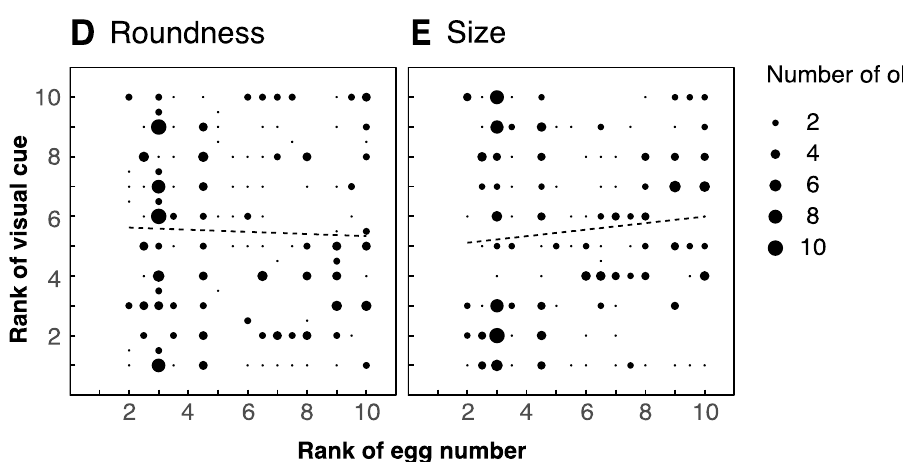
Figure 4. Correlation between morphological features of leaves and number of eggs laid. Height (( A ): r = 0.285, p ≤ 0.01), orientation (( B ): r = 0.021, p = 0.751), flatness (( C ): r = 0.229, p < 0.01), roundness (( D ): r = − 0.033, p = 0.620) and size (( E ): r = 0.998, p = 0.131). Thick regression lines denote significant correlations, dashed lines indicate non-significant correlations. Data is based on 50 leaves from five trees.